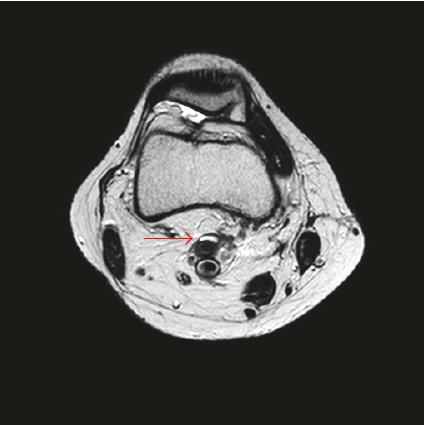
Figure 7: Postoperative MRI revealed 5 square mm of high intensity adventitial area (arrow) that was suspected as remaining cystic